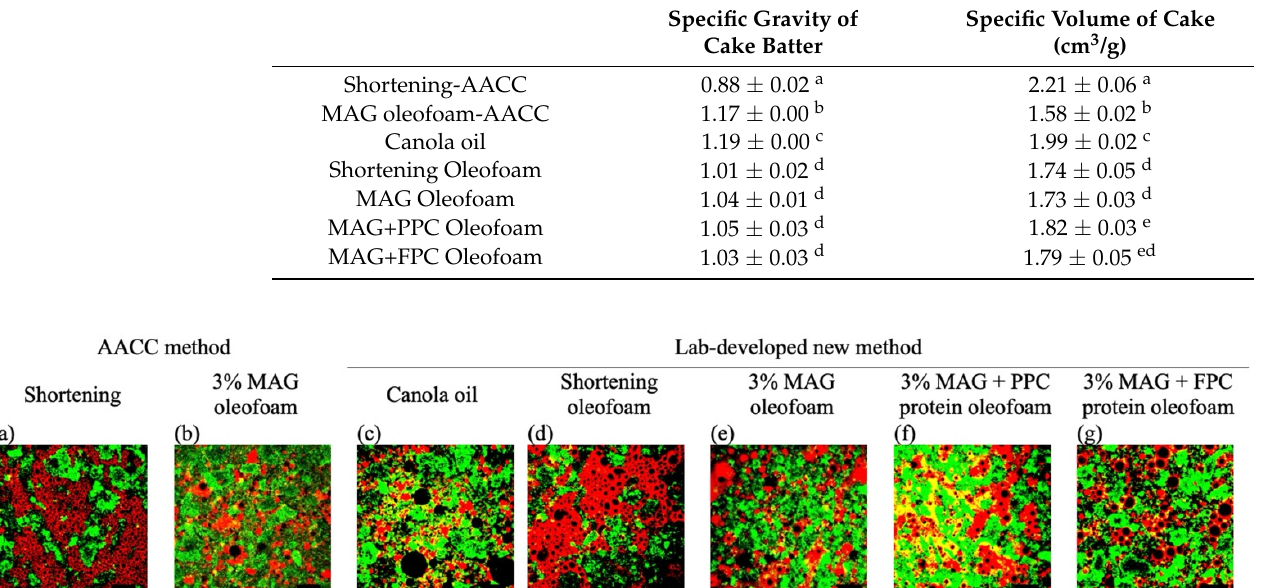
Table 1. The specific gravity of different cake batters and specific volume of corresponding cakes made with shortening and MAG-oleofoam using the AACC method and a lab-developed method. Different letters in each column indicate statistically significant differences among the mean ( p < 0.05).